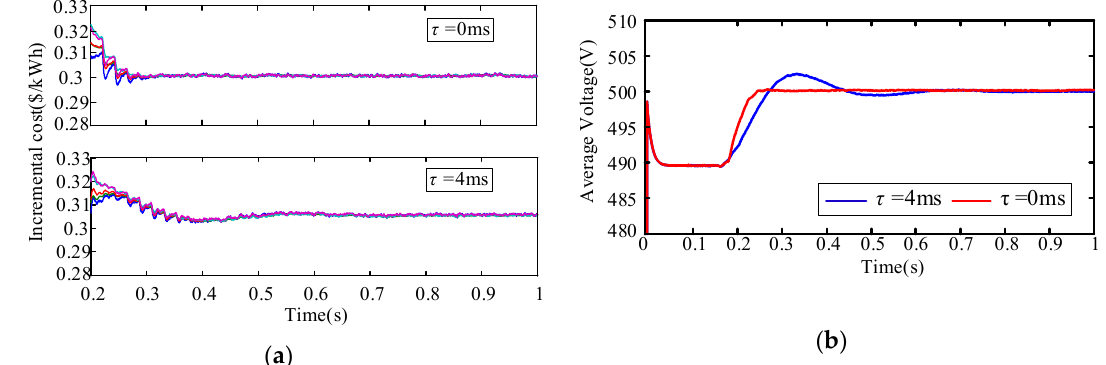
Figure 17. Performance of the optimal topology. ( a ) the incremental costs under different delays; ( b ) the average voltages under different delays.